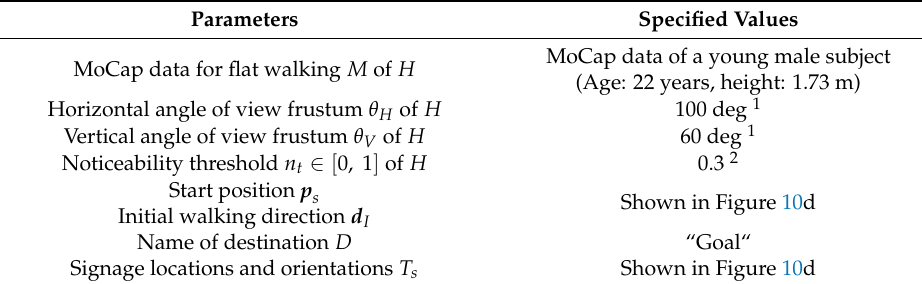
Table 5. User-assigned parameters of signage